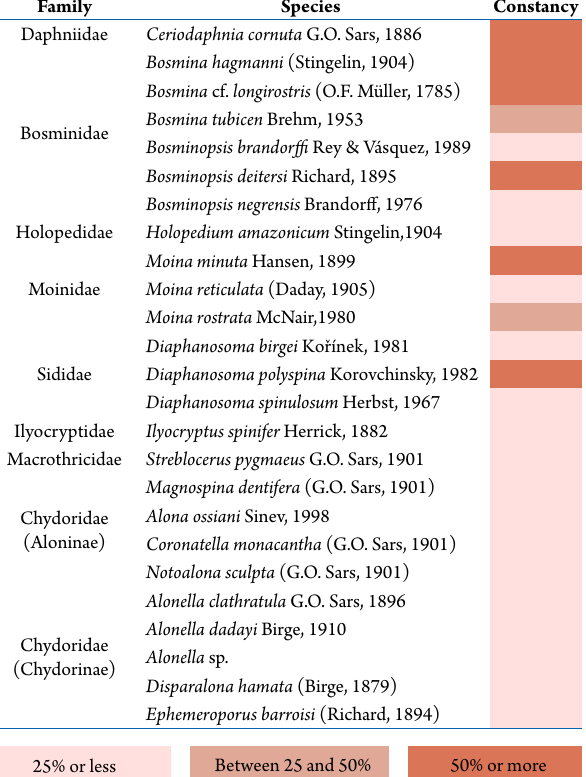
Table 1. Dajoz’s constancy index and relative abundancy of the species of planktonic cladocerans (Crustacea: Anomopoda and Ctenopoda) in Tupé Lake, between April 2008 and February